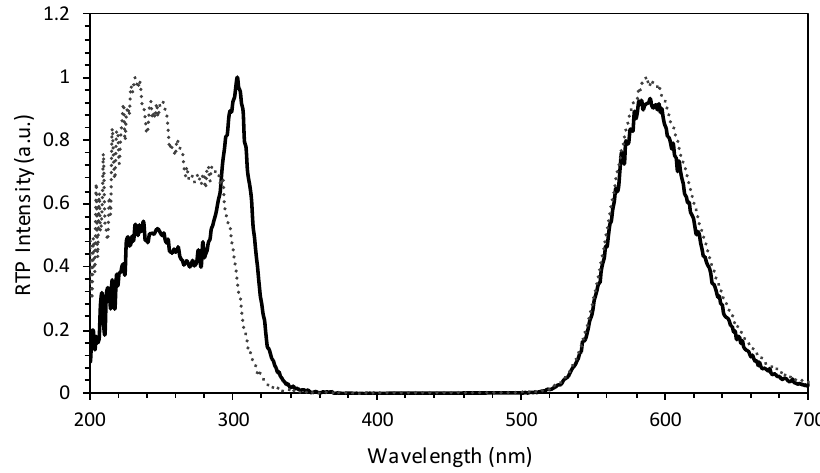
Figure 2. Photoluminiscent excitation/emission spectra of colloidal DHLA capped Mn:ZnS QDs (dotted line) and antibody—QD conjugate (solid line).